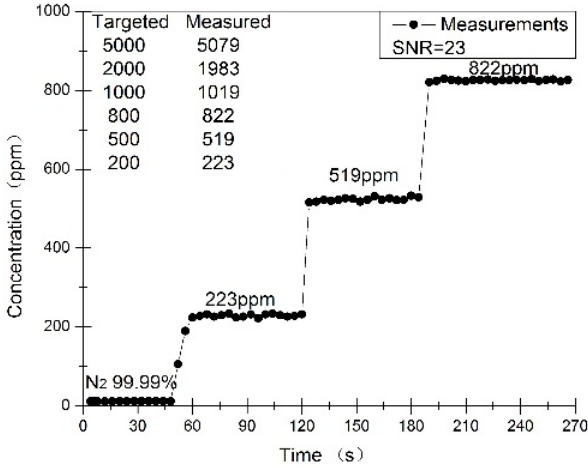
Figure 9. Measured dilution process of the 5000 ppm CH 4 reference concentration.